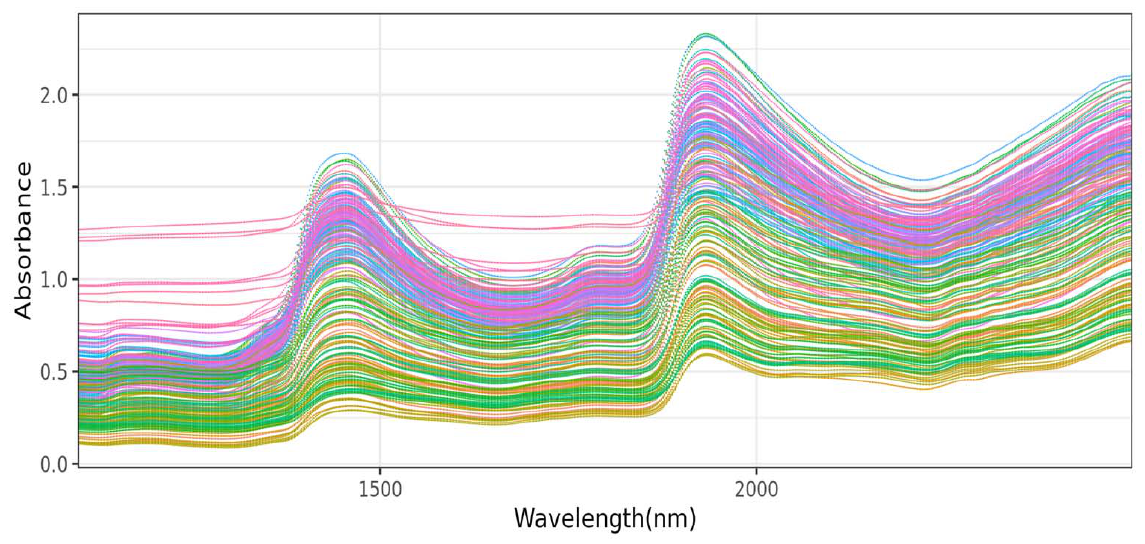
Figure 2. Near ‐ infrared spectra of fresh homogenized cattle and poultry manure samples as Figure 2. Near-infrared spectra of fresh homogenized cattle and poultry manure samples as shown shown in different line colors. in different line